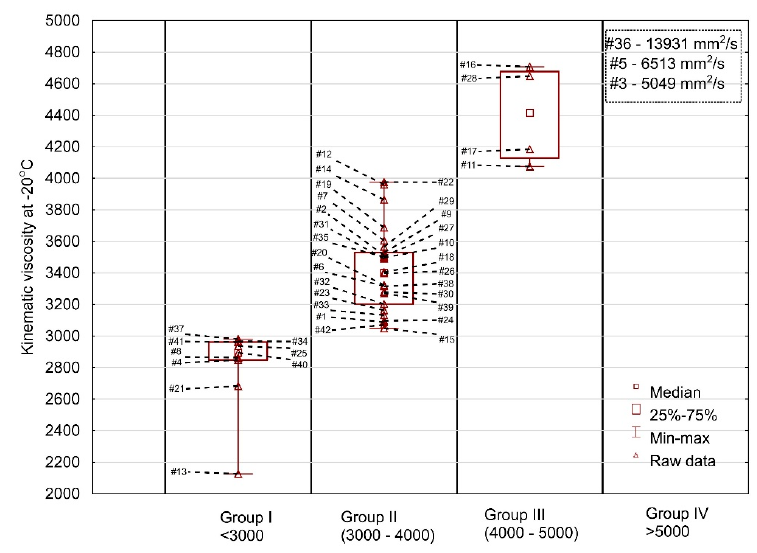
Figure 4. Kinematic viscosity of the engine oil samples tested at − 20 °C.